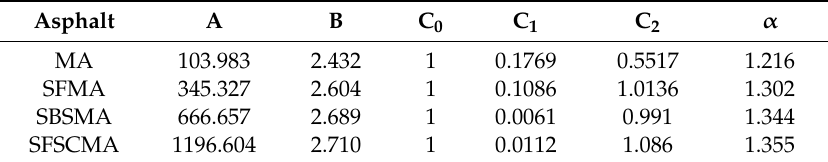
Table 14. Parameters from LAS test for di ff erent asphalts.